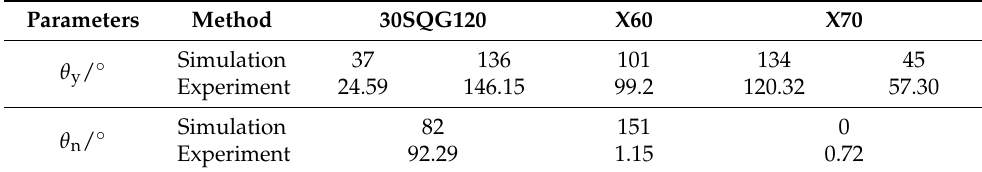
Figure 14. Normalized comparison between experimental results under different detection parameters and simulation results: ( a ) 30SQG120, ( b ) B50A470, ( c ) X60, and ( d ) X70. Table 4. Characteristic parameters of magnetic anisotropy obtained by two methods.